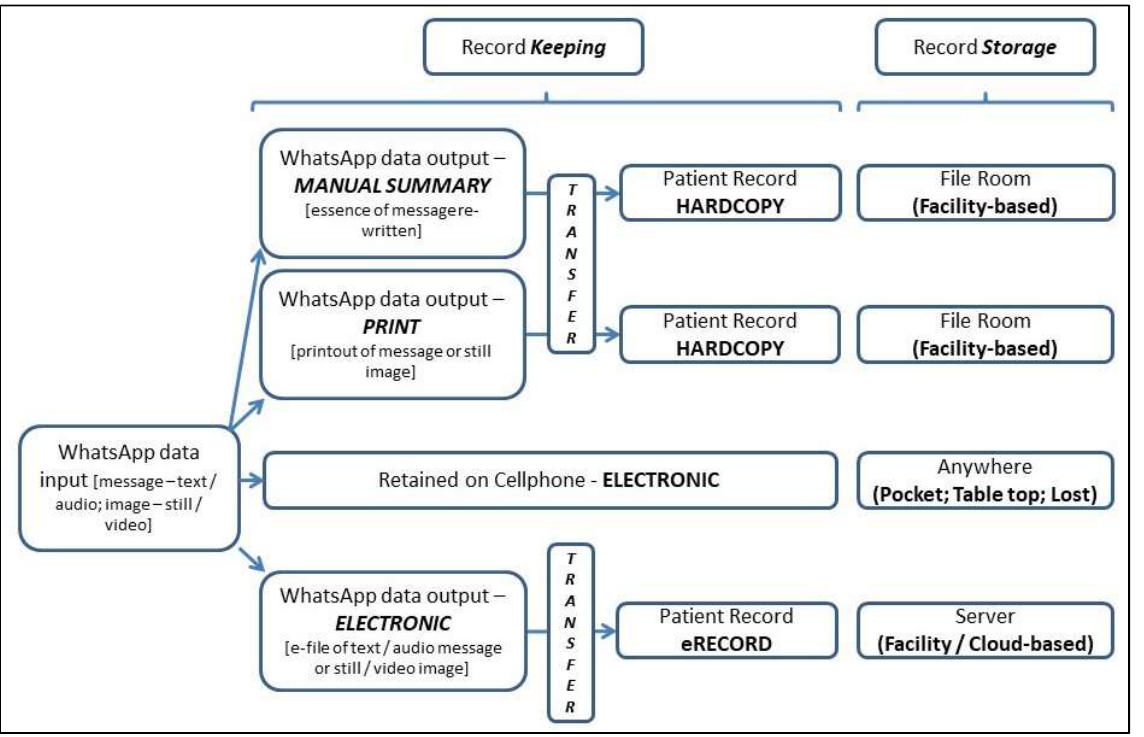
Figure 2. Options for Record Keeping and Storage of WhatsApp Messages.